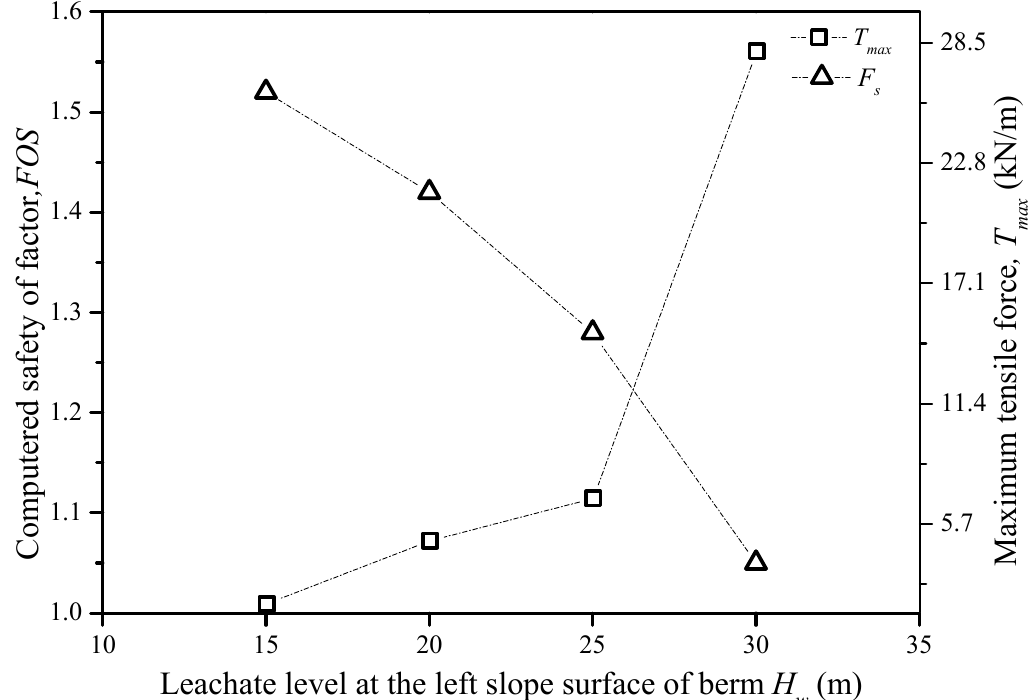
Figure 11. FOS and T max versus leachate level at the left slope surface of berm H w .